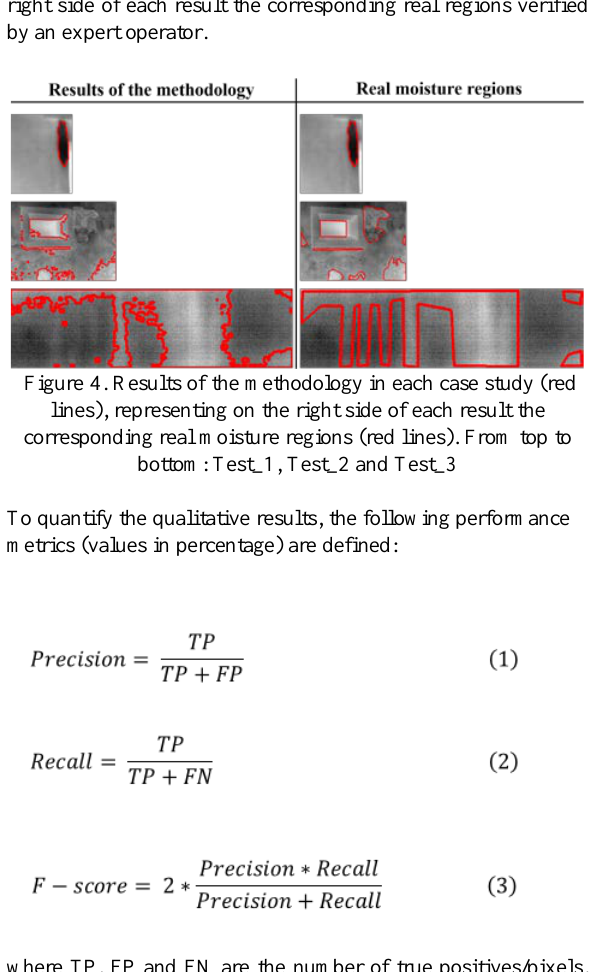
where TP, FP and FN are the number of true positives/pixels, false positives/pixels and false negatives/pixels, respectively and regarding between the detected and the real moisture areas. Results of precision, recall and F-score performance metrics for each case study, and the global average and standard deviation, are shown in Table 1.